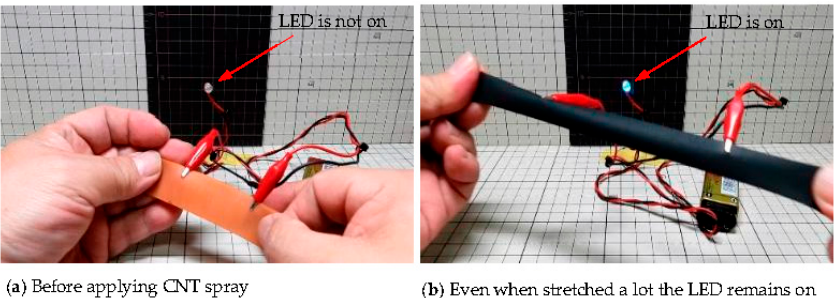
Figure 21. Ultra-flexible thin film electrode formation by SWCNT spray. ( a ) Elastomer (orange) before applying SWCNT spray. Naturally, the LED does not turn on. ( b ) After spraying the SWCNT, even if it is stretched considerably, the LED is still fully shining.